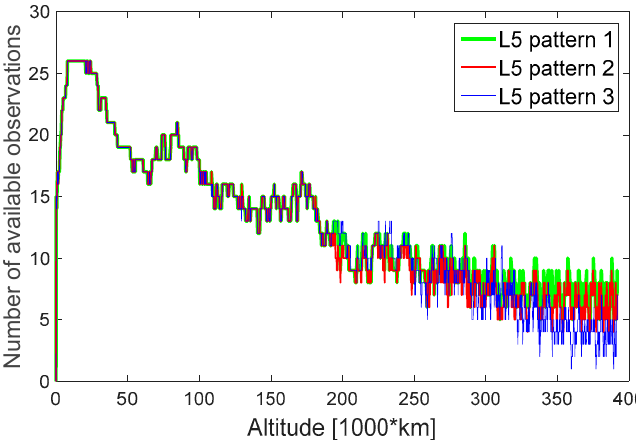
Figure 24. Number of available observations during the assumed MTO.